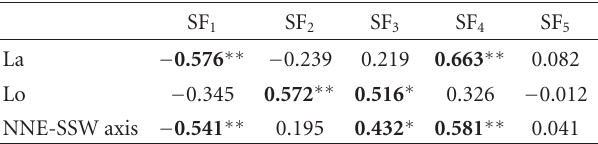
Table 2: Pearson’s correlation coe ffi cients between the spatial filters and the geographical